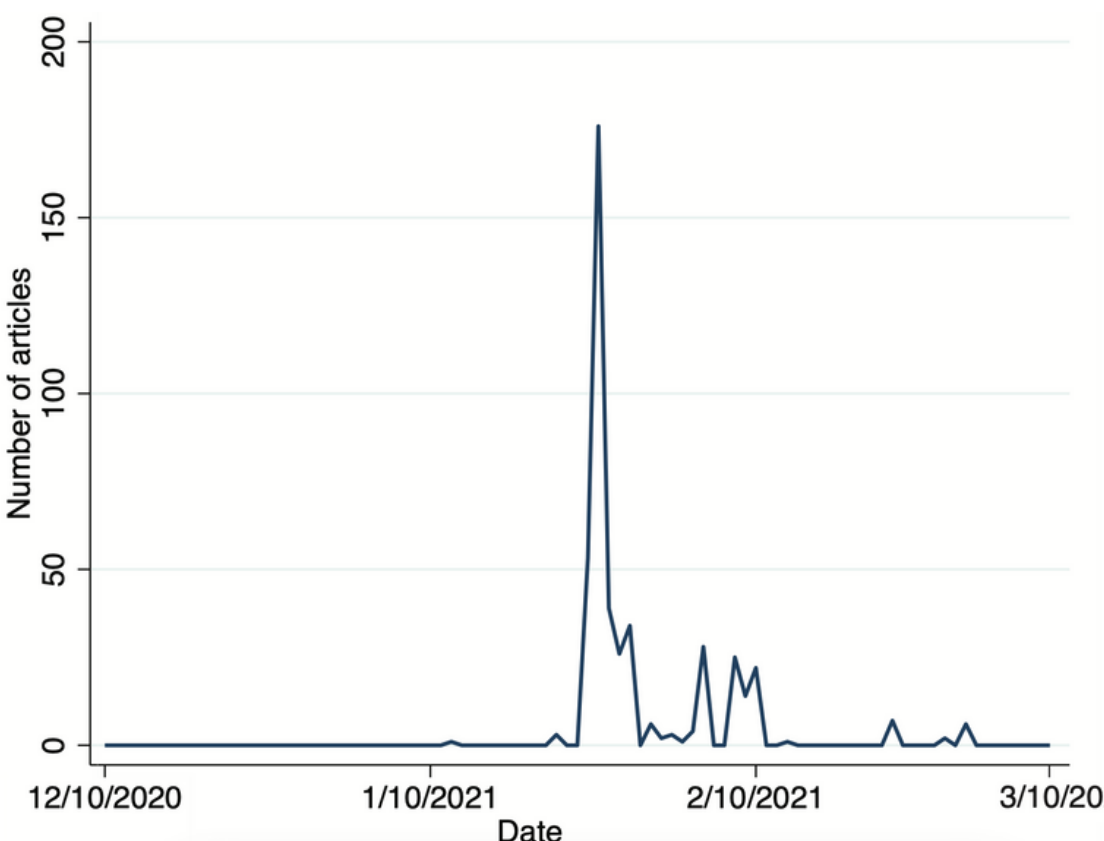
Figure A1. Time-Series Plot of Newspaper Articles Discussing Maduro’s “Miracle Cure” Table A1. Misinformation themes, topics, myths, and phrases.